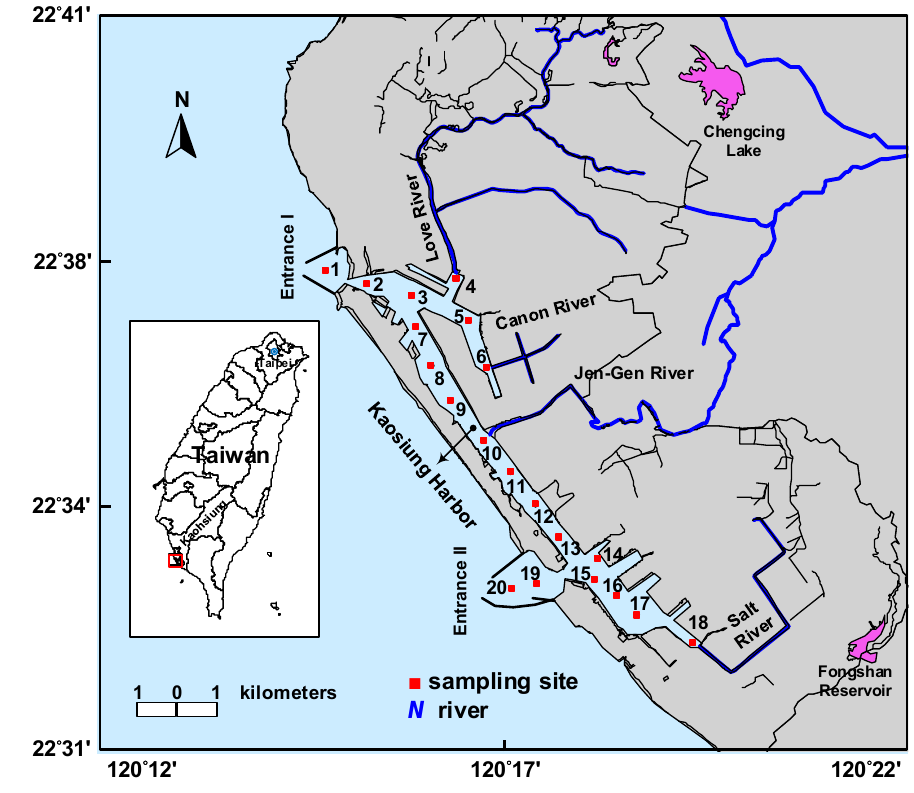
Figure 1. Map of the study area and location of the sampling stations.